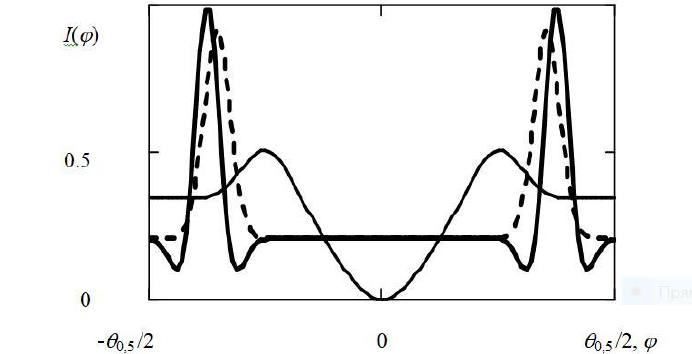
Fig. 4. The reconstructed image of the source using MHAT